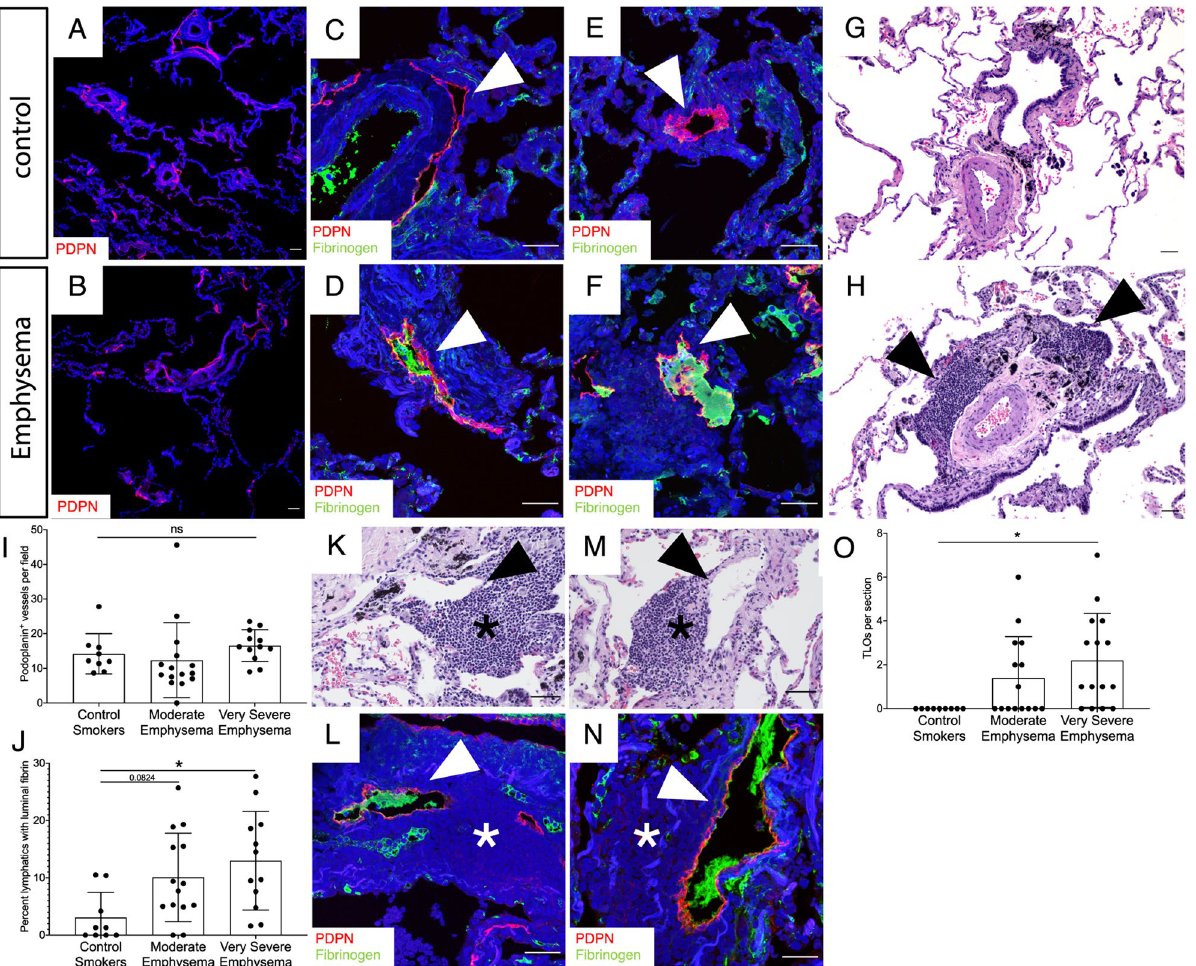
Figure 2. Lymphatic thrombosis in human emphysema. ( A , B ) Representative fluorescent immunohistochemical analysis of lung tissue from patients with emphysema or control smokers for the lymphatic marker PDPN (red). ( C – F ) Immunohistochemical staining for lymphatic thrombosis using PDPN (red) and fibrinogen (green) in lung tissue from patients with emphysema ( D , F ) and control smokers ( C , E ). Lymphatics (red) are indicated by arrowheads. ( G , H ) H&E staining of lung tissue revealed TLOs in emphysema ( H , arrowheads) but not control lung tissue ( G ). ( I ) Quantification of PDPN + lung lymphatics in tissue from control smokers and patients with moderate and very severe emphysema. ( J ) Quantification of PDPN + lymphatic vessels with luminal fibrin. ( K – N ) Serial H&E and immunohistochemistry serial sections ( K , L and M , N ) of lung tissue from patients with very severe emphysema demonstrating thrombosed lymphatics (arrowheads) spatially associated with TLOs (asterisks). ( O ) Quantification of TLOs in human lung tissue. Quantification lung lymphatic vessels was performed by counting PDPN + lymphatics in 10 × images of lung tissue sections. At least 3 10 × images were used for each patient tissue sample and the average lymphatic number was determined. Lymphatic thrombosis was quantified as the percentage of PDPN + lung lymphatics with luminal fibrin in each 10 × image and was averaged from at least 3 10 × images. TLOs were quantified as the total number of TLOs visualized in each lung tissue sample using H&E staining. All values are means ± SEM. P value calculated by ANOVA. * P < 0.05. ns not significant. Scale bars = 25